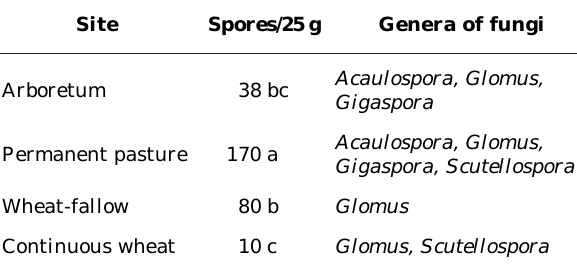
Table 2. Number of spores and genera of fungi present in different ecosystems in